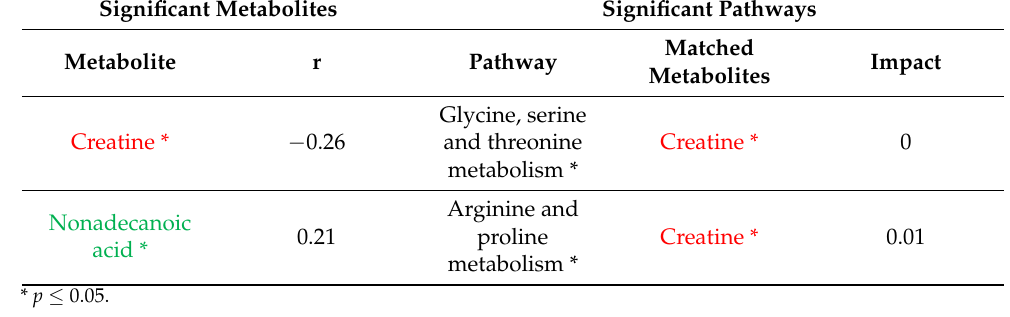
Table 11. Metabolites and their pathways which correlate with the total glutathione redox ratio.